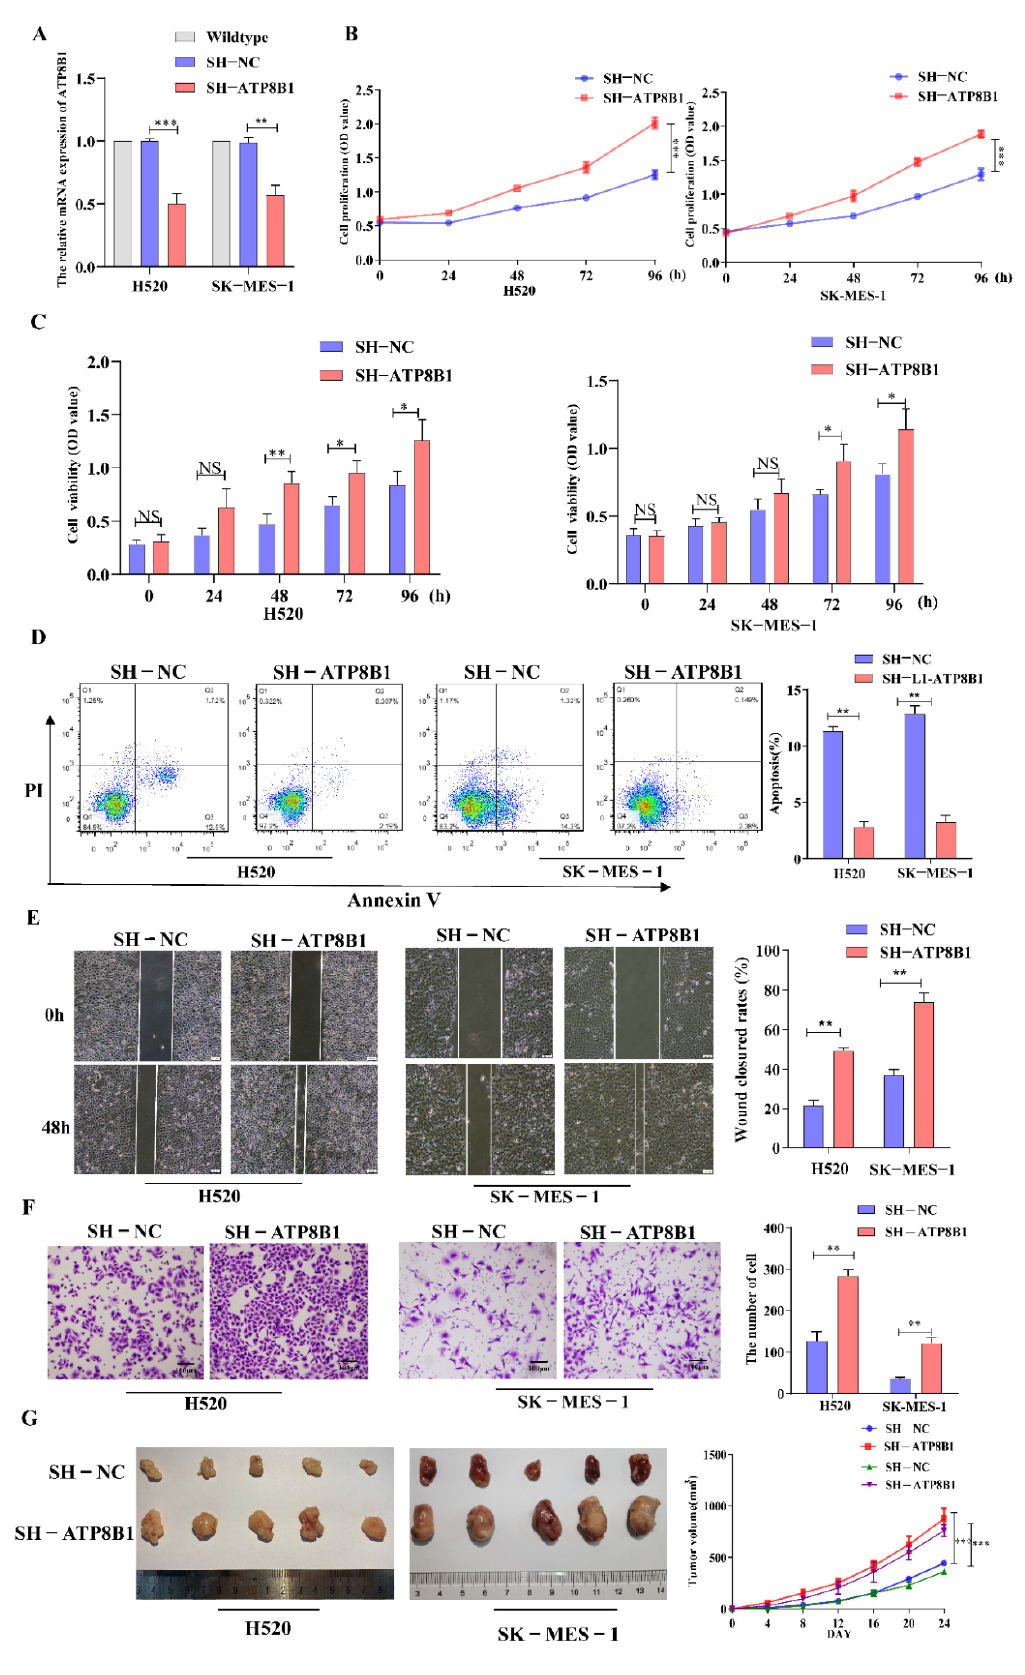
Figure 2. Interference of ATP8B1 promotes malignant progression in vitro and in vivo. ( A ) Expression of ATP8B1 in H520 and SK-MES-1 cells. All the RT-qPCR results shown for H520 SH-NC and H520